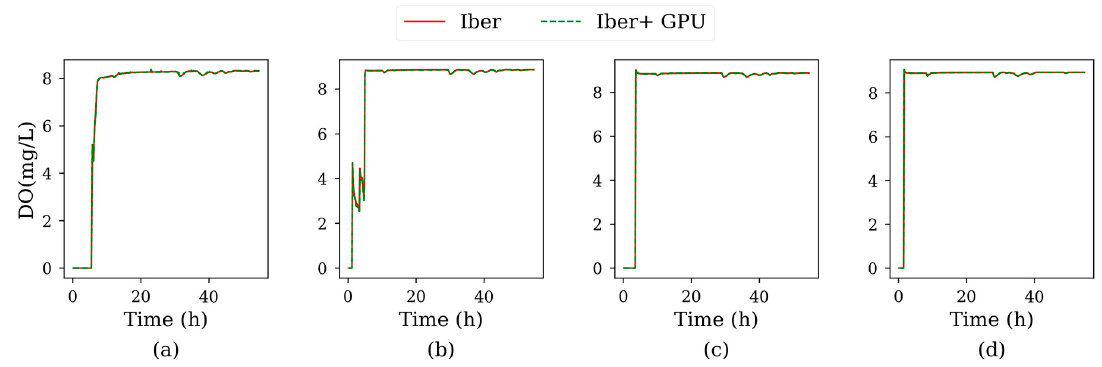
Figure A1. Time series of dissolved oxygen for Test 3, sampled at control points P1 ( a ), P2 ( b ), P3 ( c ) and 4 ( d ).